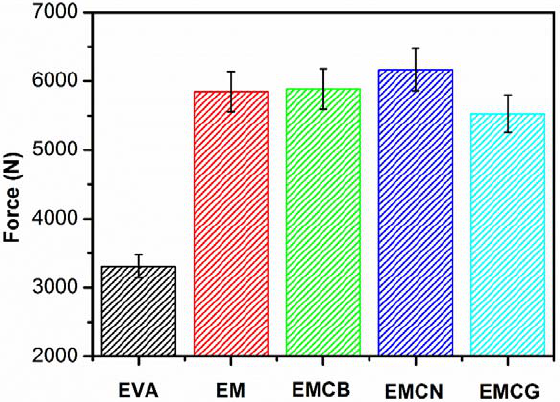
Figure 8. Force of EVA with MH and different carbon materials after mixing for 15 min at 180